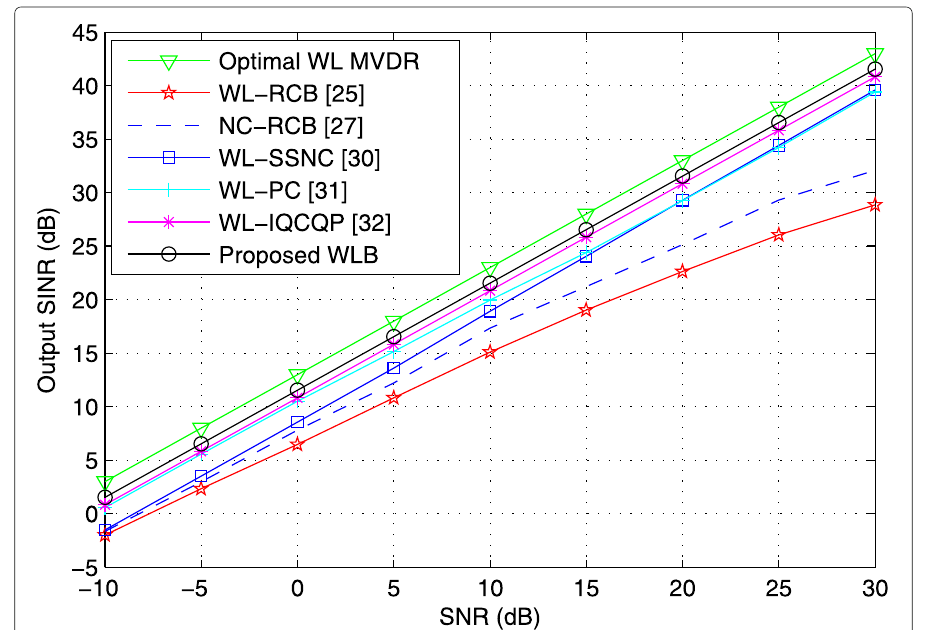
Fig. 4 Example 2. Output SINR of all WLBs versus the input SNR